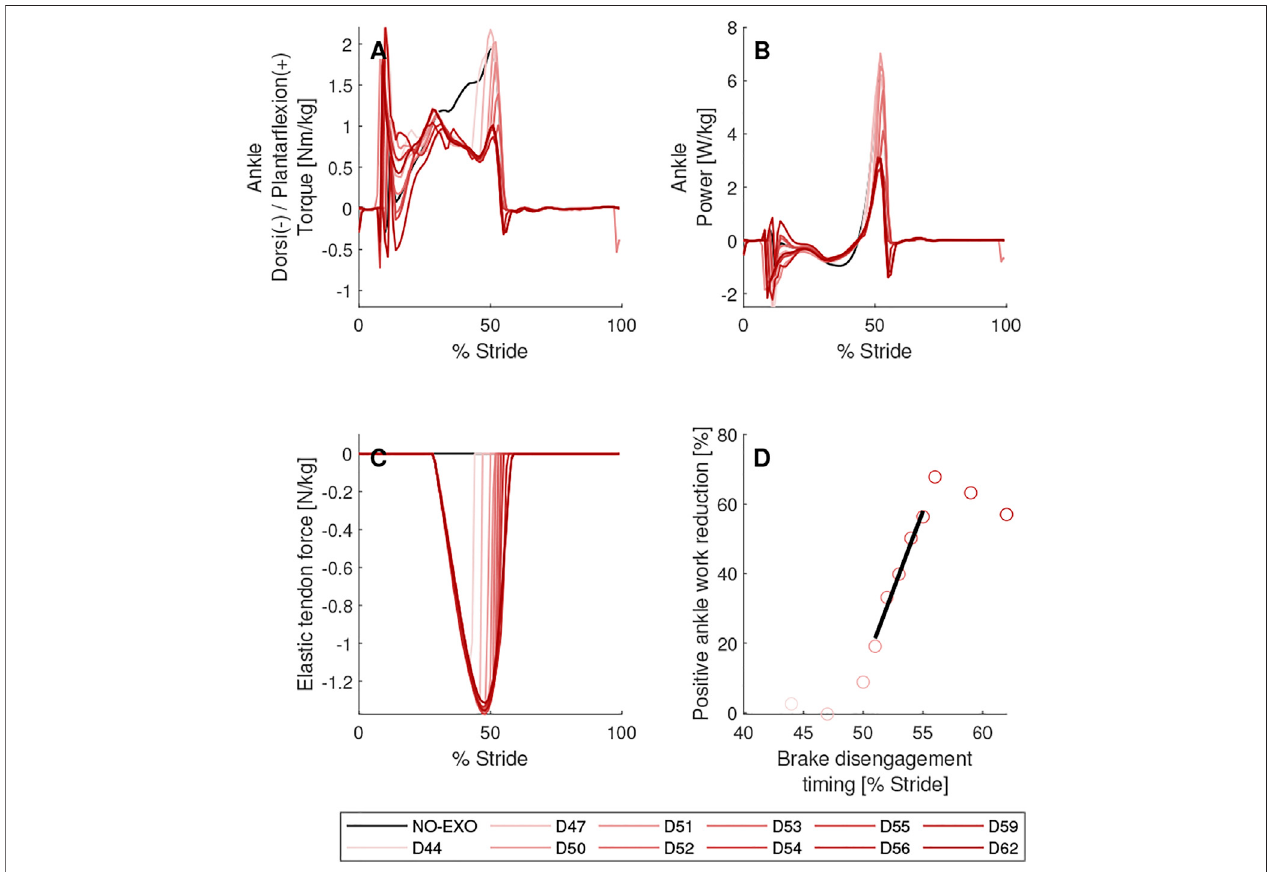
FIGURE8| Brakedisengagementtimingparametersweep.Biologicaltorques (A) andpowers (B) areshownfortherightlegonwhichAN-EXTRA-Pushisworn.In (C) , force in the elastic tendon is shown. In (D) , linear regression between brake disengagement timing and positive ankle work reduction is shown. Elastic tendon stiffness value was set to 4.85 N/m/kg and brake engagement timing was set to 29% of stride. Conditions are abbreviated and color coded as follows: without exoskeleton(NO-EXO)(black)andactiveexoskeletonassistance withbrakedisengagementtimingsof{44,47,50,51,52,53,54,55,56,59,62} %ofstride (D44, D47, D50, D51, D52, D53, D54, D55, D56, D59, D62) (red; from light to dark in the same